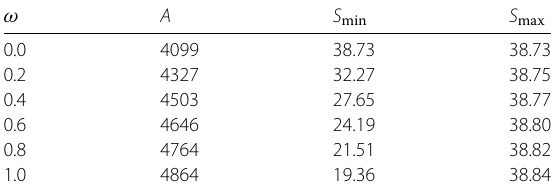
Table 3 Numerical calculation of annual attack rates (A) and max-min of S by varying ω ω A S min S max 0.0 4099 38.73